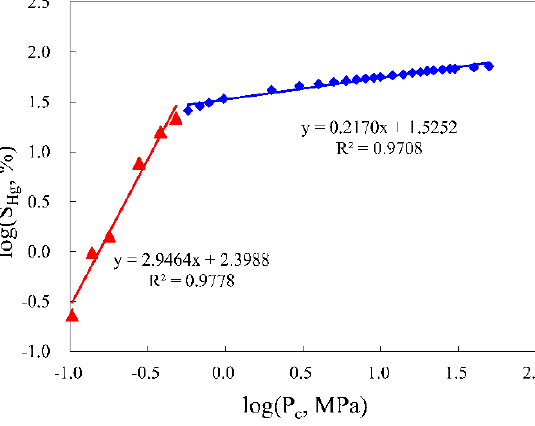
Figure 3. Plots of log( S H g ) vs. log( P c ) from the mercury intrusion curve of sample 22.